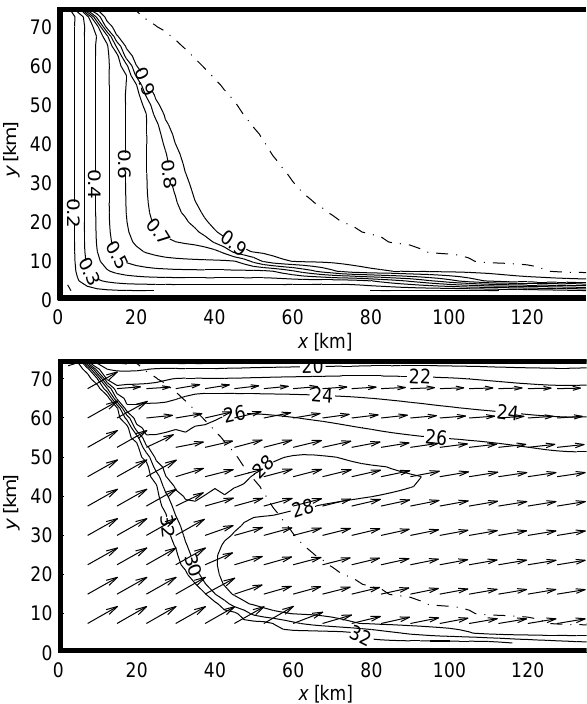
Fig. 10. The ice concentration ( A , top) and speed and velocity ( v and | v | , bottom) using the new-ice thickness parametrisation by Mellor and Kantha (1989) after eight model days. The resulting polynya is very small with no discernible edge in the velocity field. The dash-dotted line shows the isoline for A =0.8 from the control